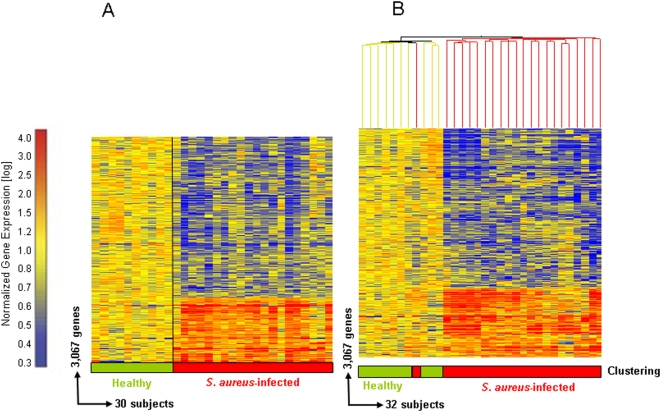
Gene expression biosignature in PBMCs from S. aureus patients and healthy controls.(a) Statistical group comparisons between 10 healthy subjects and 20 patients with acute S.aureus infections yielded 3,067 genes expressed at statistically different levels (Mann-Whitney p<0.01 and 1.25 fold change) between the two groups. Significant genes were organized by hierarchical clustering to reveal differential expression, each row representing a single gene and each column an individual subject. Transformed expression levels are indicated by color scale: red representing relatively high and blue relatively low gene expression compared to the median expression for each gene across all patients compared to healthy controls. (b) The same 3,067 gene list was used to perform a condition tree on 22 new subjects with S. aureus infections and correctly grouped 21 of the 22 patients based solely on gene expression.